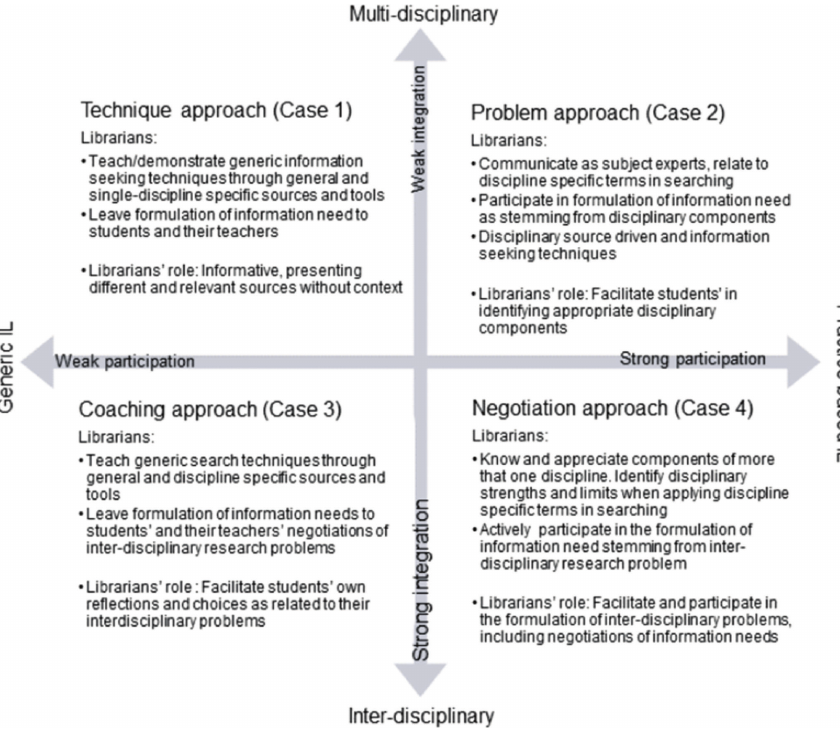
Fig. 1: Bøyum et al.’s model of library instruction